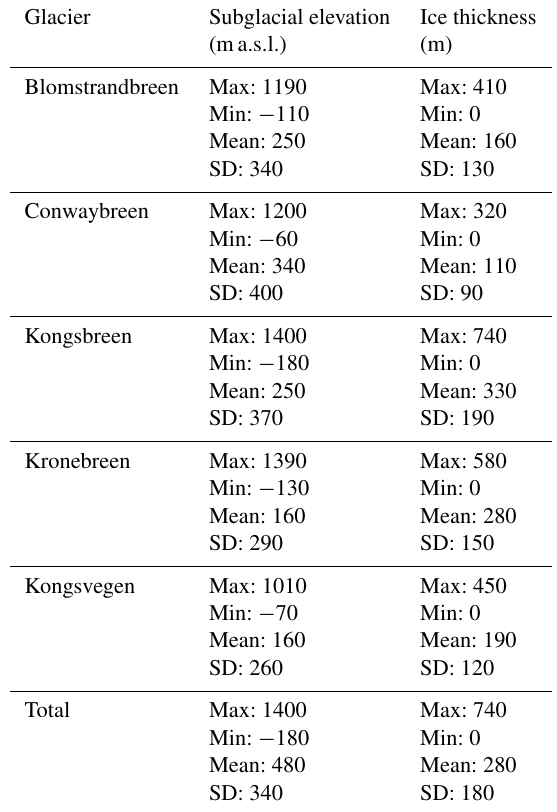
Table 1. Statistics for each glacier with subglacial elevation and ice